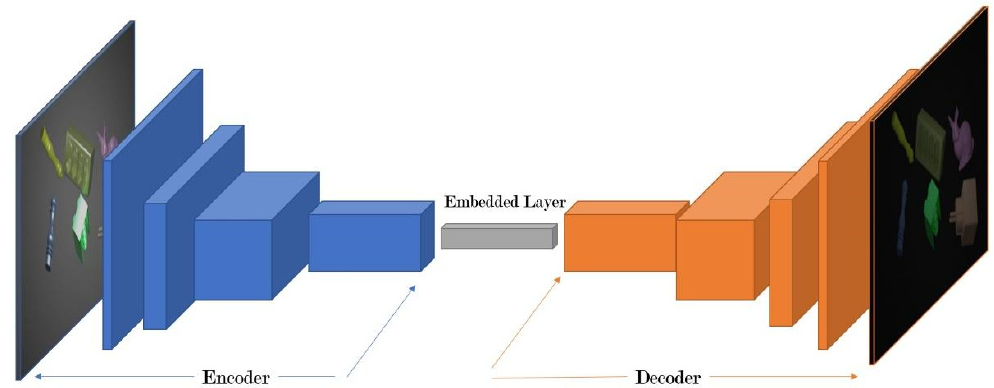
Figure 10. The basic architecture of the implemented CAE network.